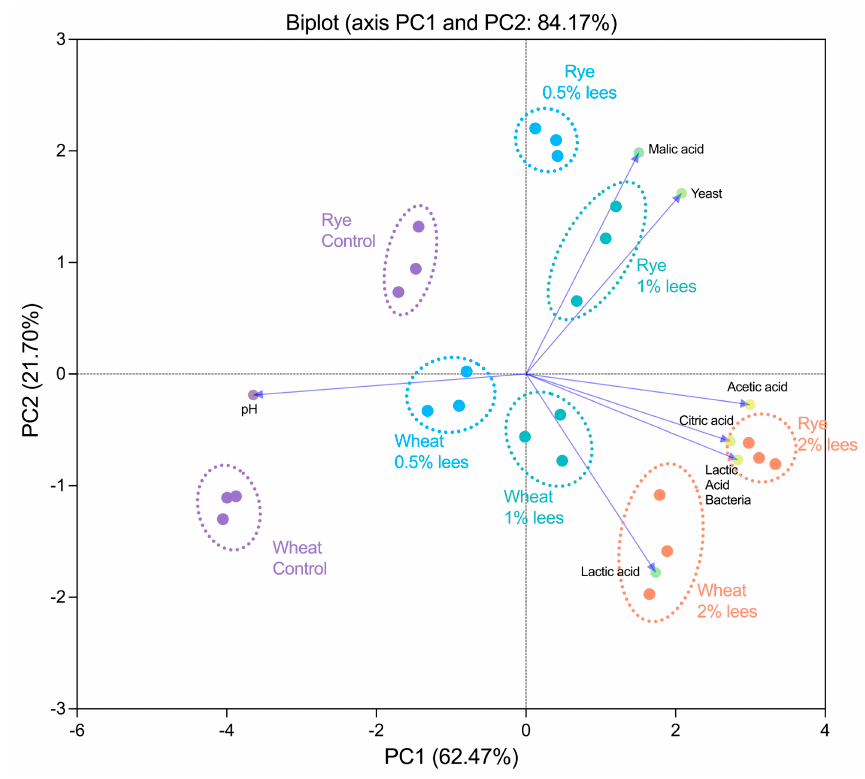
Figure 4. Principal component analysis (PCA) biplot of sourdoughs obtained at the end of fermentation.